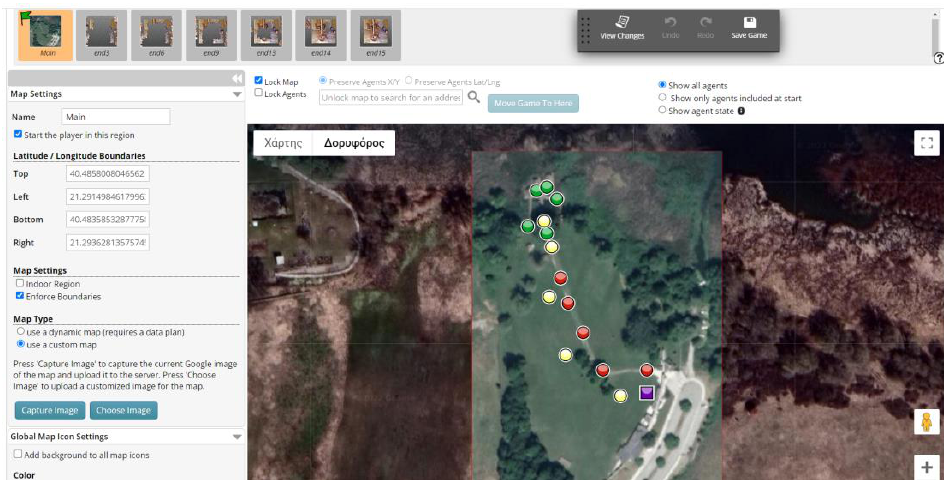
Figure 4. Setting the region of the game in Taleblazer and inserting GPS points associated with mul- timedia content (agents).